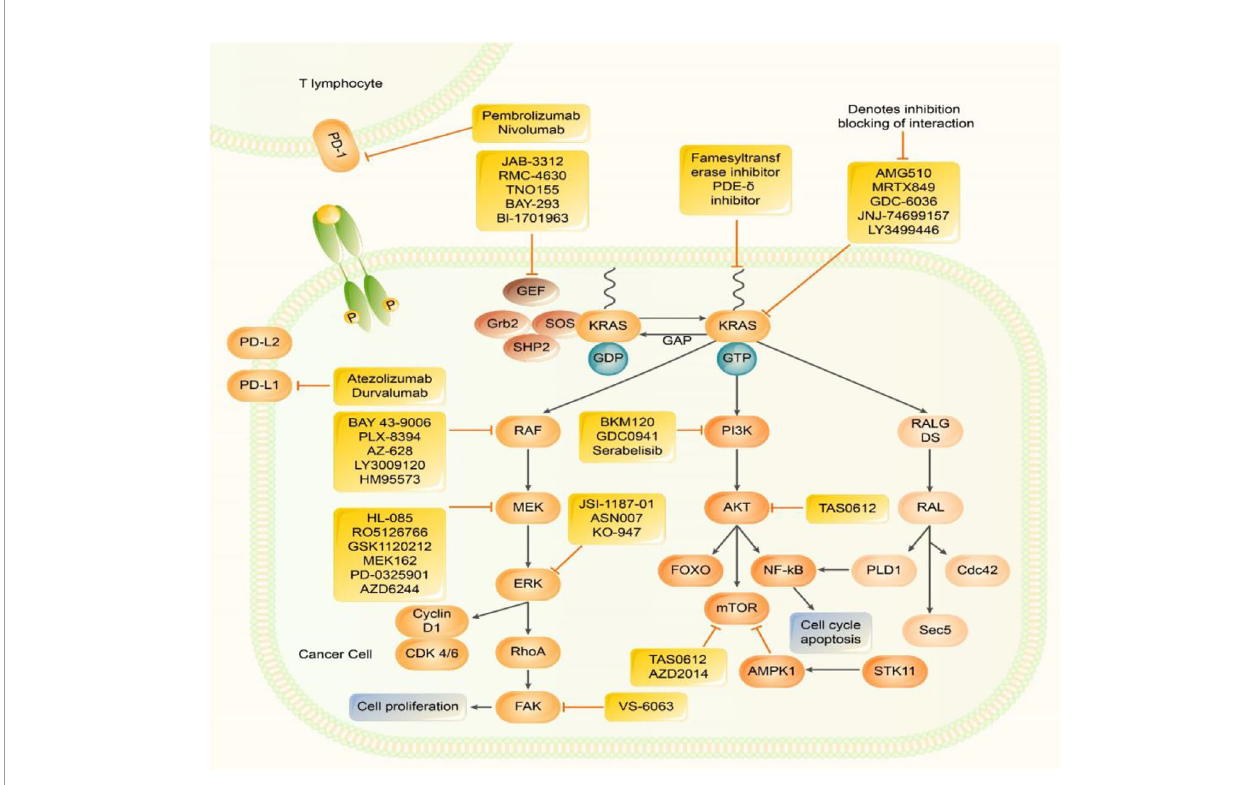
FIGURE 1 | Inhibitors of Kirsten rat sarcoma viral oncogene homolog (KRAS) effector signalling. RAS protein acts as a binary molecular switch in a variety of signal transduction pathways. It is active when combined with GTP, but doesn ’ t have activity when combined with GDP. The GDP/GTP cycle is regulated by GEFs, which can promote the formation of active RAS - GTP and GAP stimulates GTP hydrolysis and forms inactive RAS - GDP. Normal RAS can be activated by upstream signalling factors, which in turn activates multiple downstream signalling pathways, including: MAPK, pathway; PI3k - AKT - mTOR, and pathway; RALGDS pathways. MAPK pathway, PI3K, pathway and JAK-STAT pathways promote the transcription of genes related to cell proliferation, metastasis, and drug resistance. PD -1 exists on the surface of activated T cells. When it is combined with PD-L1/2, it causes a series of immunosuppressive effects. Many Several methods have been developed to directly inhibit KRAS and inhibit KRAS downstream signalling pathways. Many new treatment strategies for KRAS inhibitors, KRAS downstream signalling pathway inhibitors, and ICIimmune checkpoint inhibitors are under